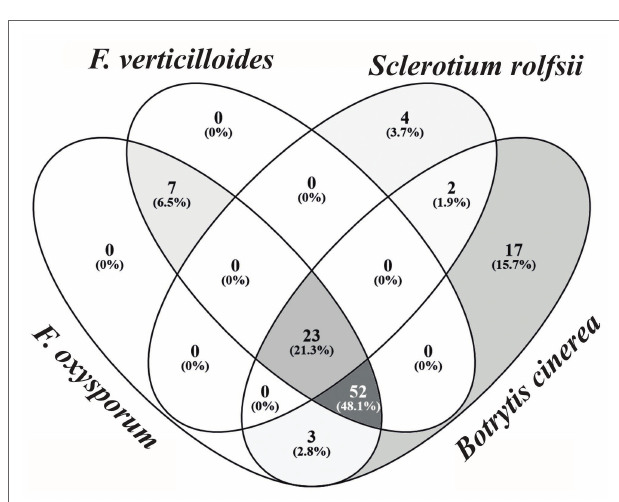
FIGURE 6 | Number of bacterial isolates with antagonistic effects against fungal pathogens. Fungal pathogens included Fusarium oxysporum , Fusarium verticillioides , Sclerotium rolfsii , and Botrytis cinerea . Only bacterial antagonists showing high antagonistic activity were assigned to their respective fungi. Graph was generated using VENNY 2.1.0 (https://bioinfogp.